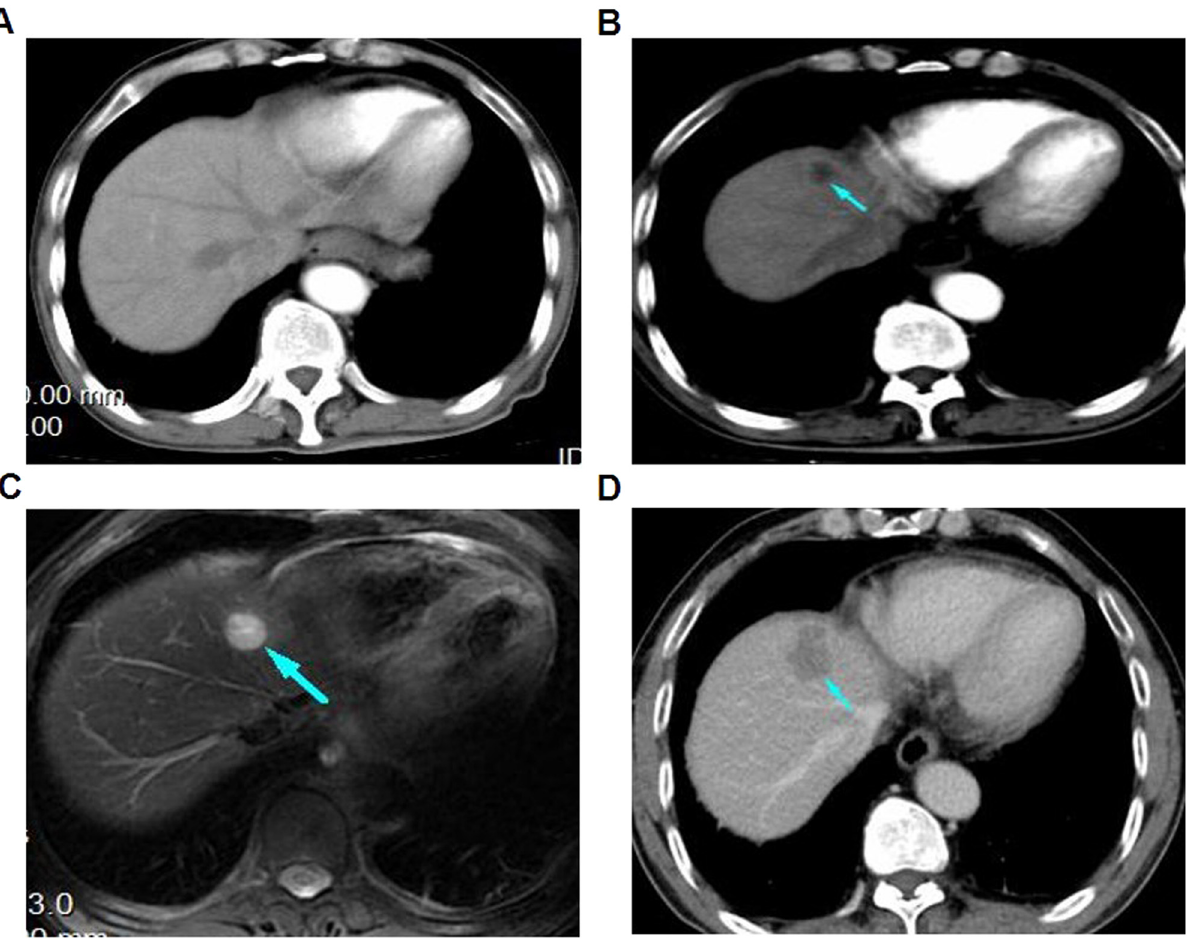
Figure 3: ( a ) Abdominal enhanced CT revealing no obvious occupying lesion in the hepatic segment IV on June 6, 2017. ( b ) Abdominal enhanced CT revealing hepatic segment IV occupation and metastasis may occur on August 30, 2017. ( c ) Abdominal enhanced MRI showing obvious occupying lesion in the hepatic segment IV, and metastasis may occur on September 5, 2017. ( d ) Abdominal enhanced CT suggesting enlarged hepatic segment IV lesions.